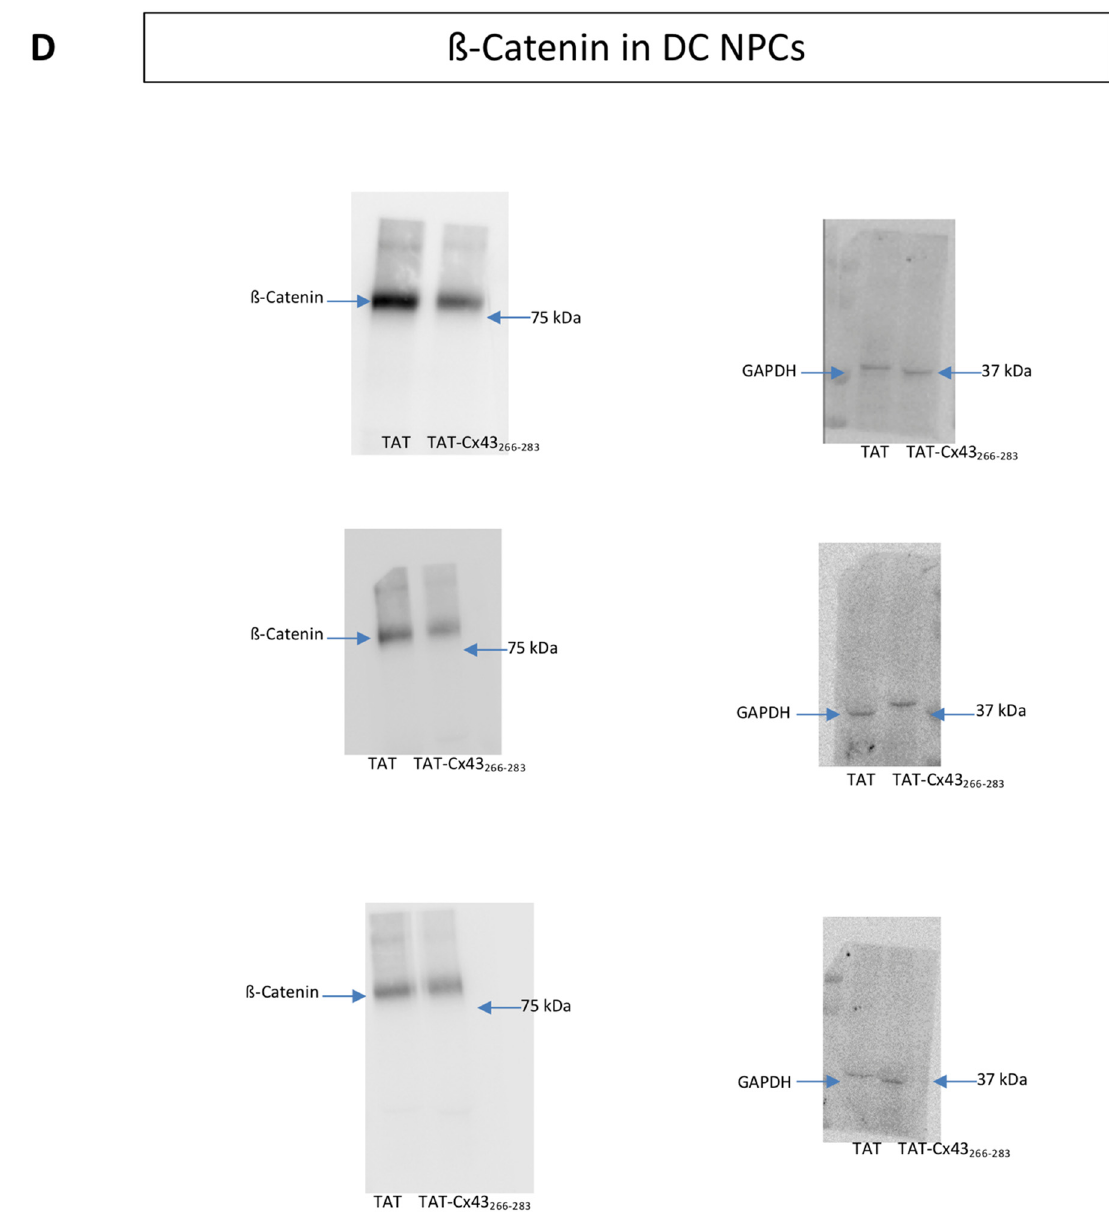
Figure A1. Full Western blots and replicates analyzed in different conditions. ( A ) Full Western blots and replicates analyzed in Figure 3C. ( B ) Full Western blots and replicates analyzed in Figure 5C,D. ( C ) Full Western blots and replicates analyzed in Figure 6A. ( D ) Full Western blots and replicates analyzed in Figure 6D.